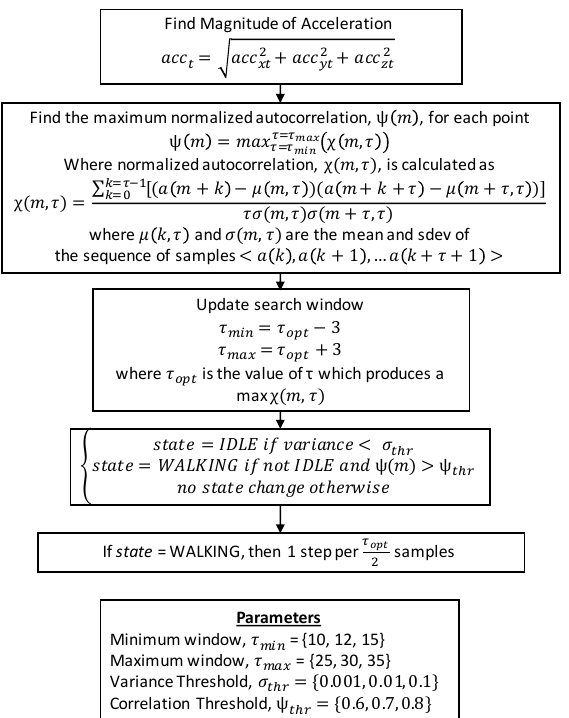
Figure 8. Flow chart describing the process for identifying steps in the autocorrelation algorithm.